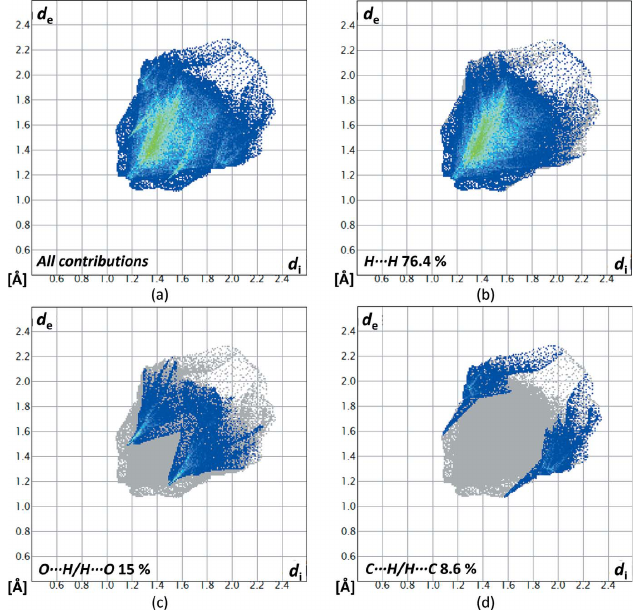
Figure 6 Two-dimensional fingerprint plots for compound 1 , showing ( a ) all contributions, and ( b )–( d ) delineated showing the contributions of atoms within specific interacting pairs (blue areas).